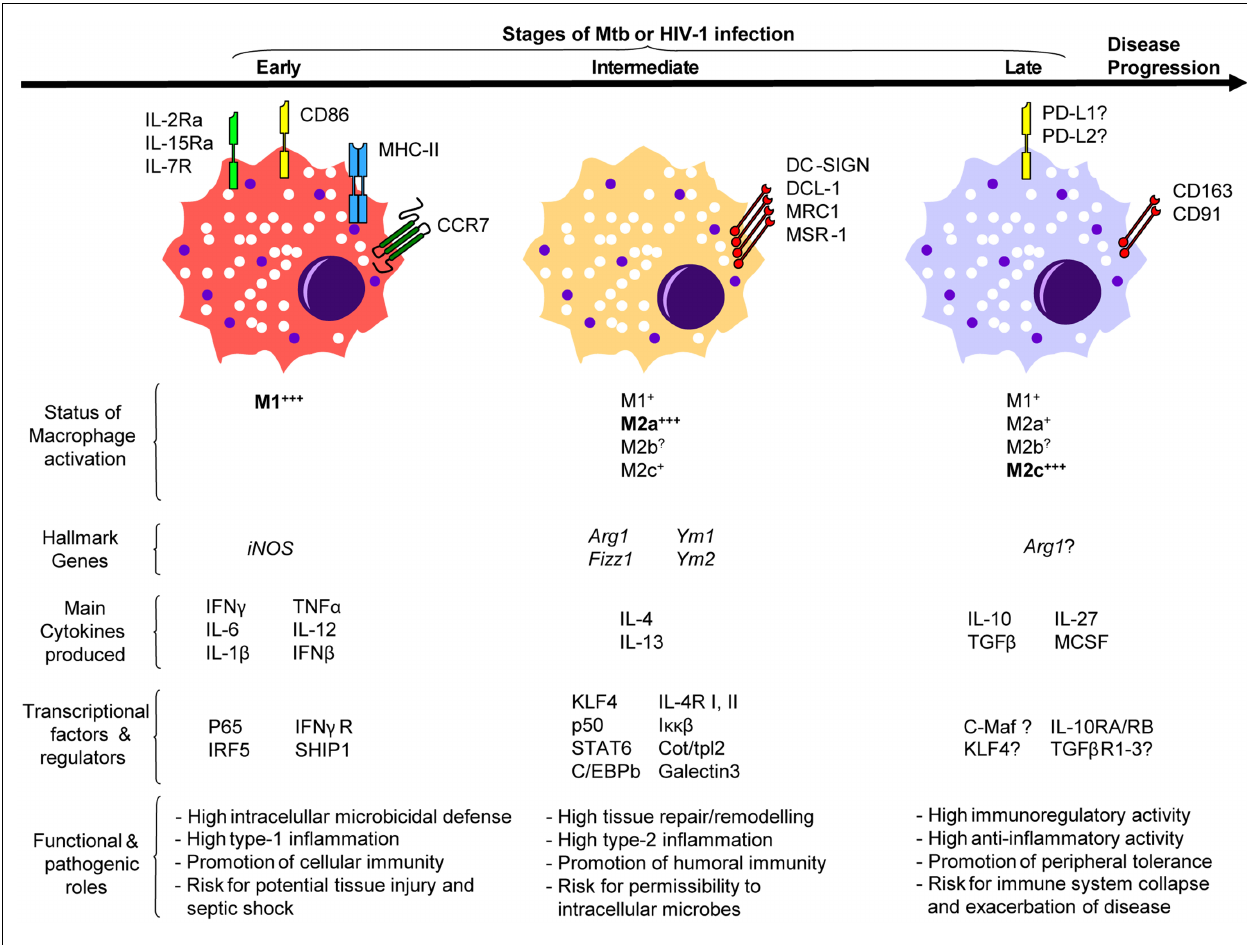
FIGURE 1 |A model illustrating the putative involvement of macrophage polarization during Mtb or HIV-1